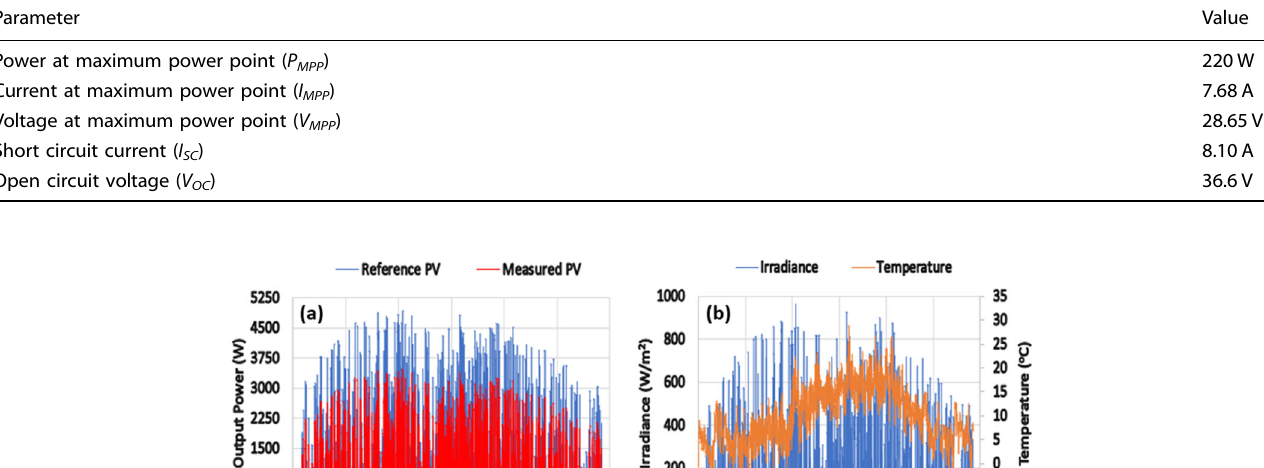
Table 2. Electrical parameters of the examined PV modules at STC